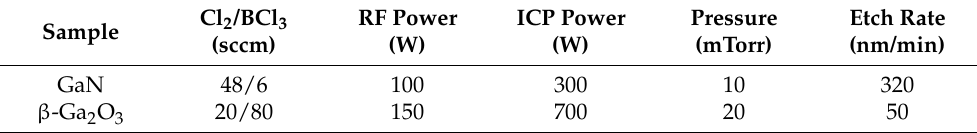
Table 1. ICP etch conditions studied for GaN and β -Ga 2 O 3